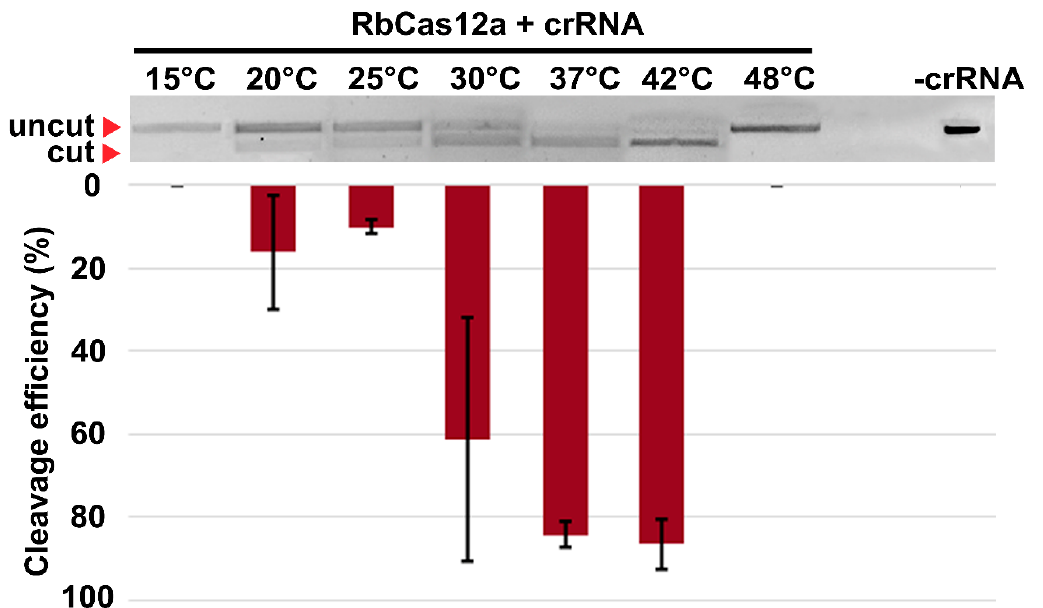
Figure 7. Thermofluor assay of RbCas12a. The left panel shows the melt curves, and the right panel shows the first derivative of the melt curves. The assay was performed with three independent replicas. The melt point of RbCas12a is 45.5 °C.